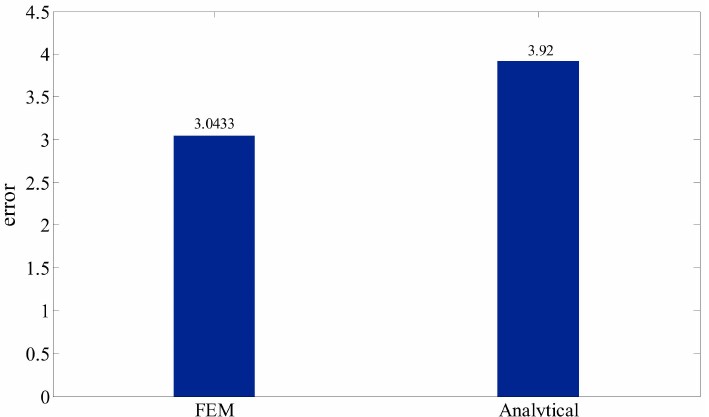
Figure 14. The value of the error function for the FEM and analytical results compared to the experimental results.